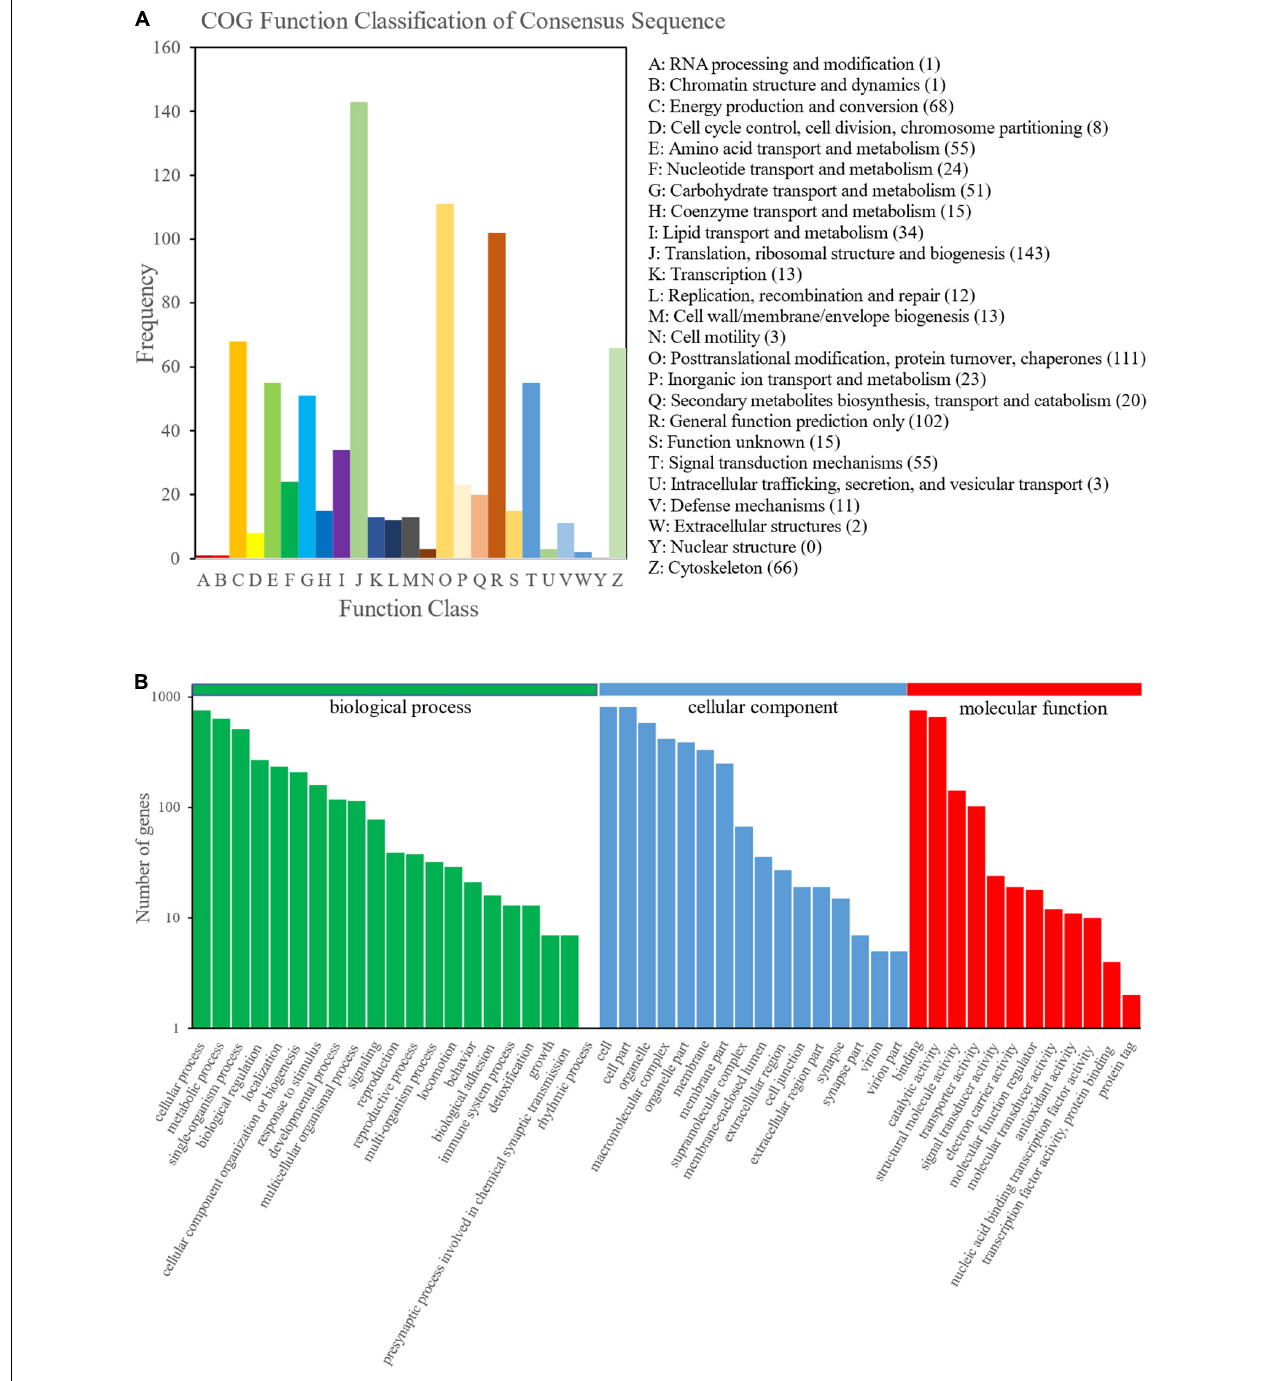
FIGURE 2 | COG and GO analysis of M. japonicus proteins. (A) COG analysis and (B) GO